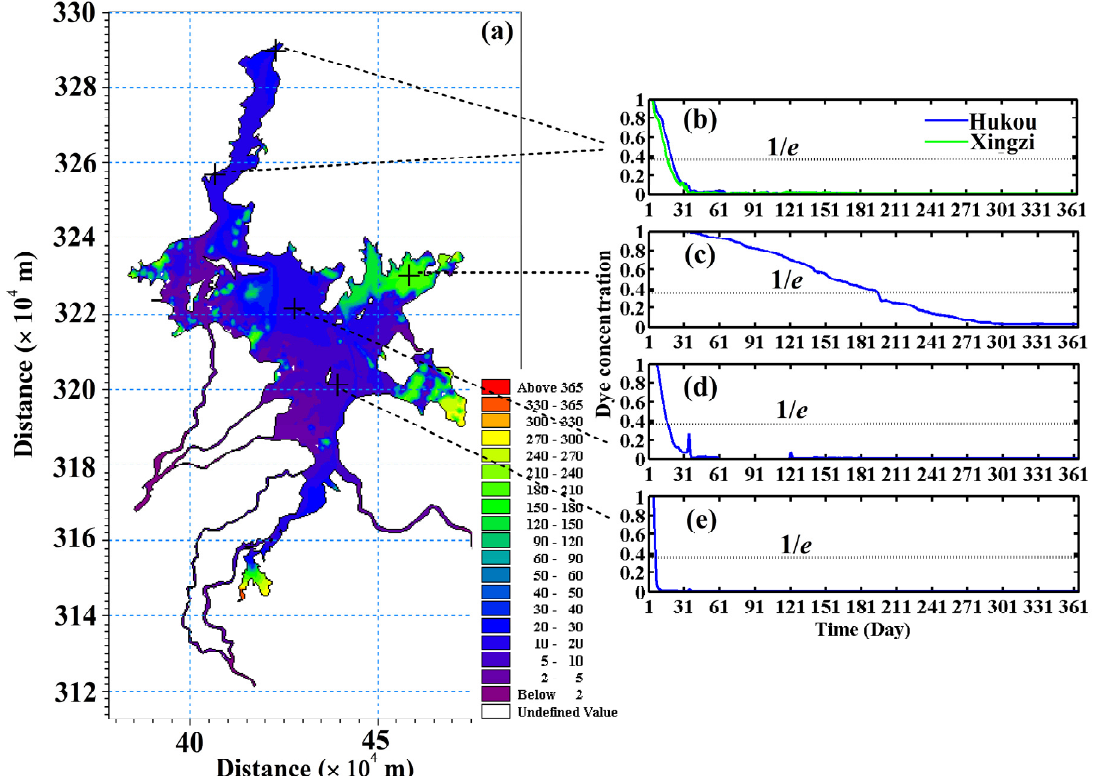
Figure 10. ( a ) Spatial distribution of the depth-averaged residence times (in days) for the water level recession period; ( b – e ) the computed dye concentrations (in kg/m 3 ) with time for the areas of interest. Releases were performed on the 1st of October during the autumn. Note that the “Undefined Value” represents dry